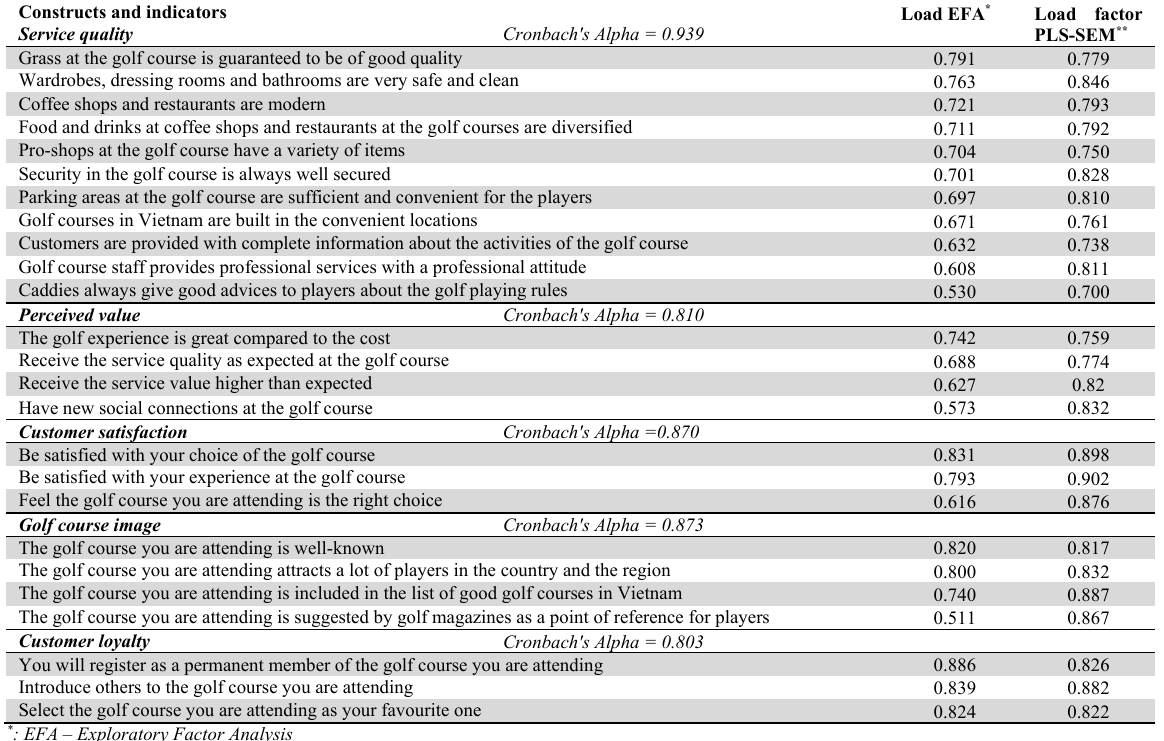
Constructs and indicators